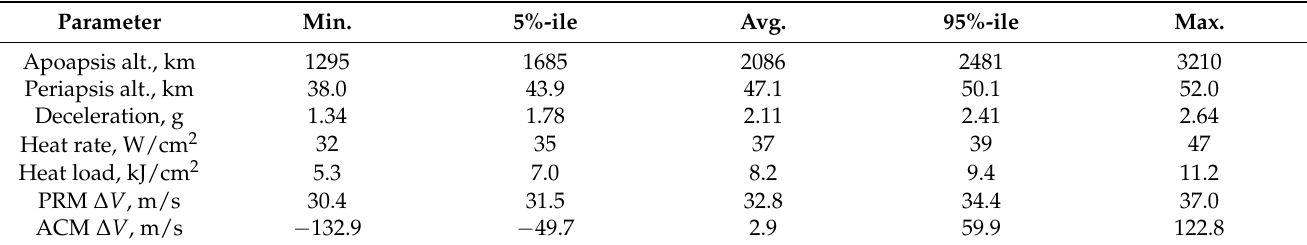
Table 6. Statistics from Mars aerocapture Monte Carlo simulations.